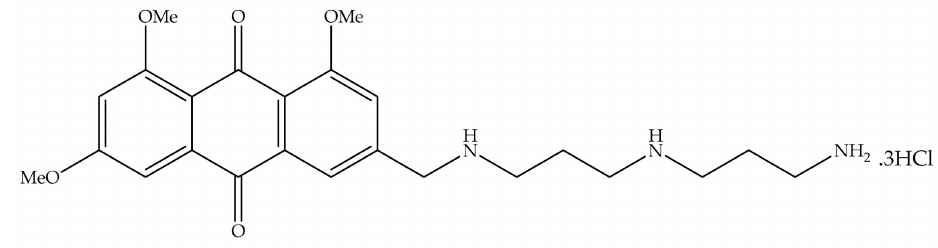
Figure 11. Chemical structure of potent targeted compound 6 .